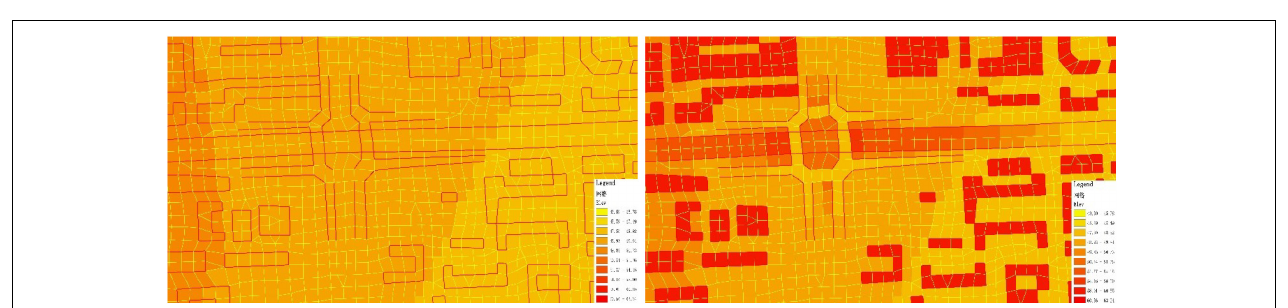
FIGURE 3 | Elevation map before and after